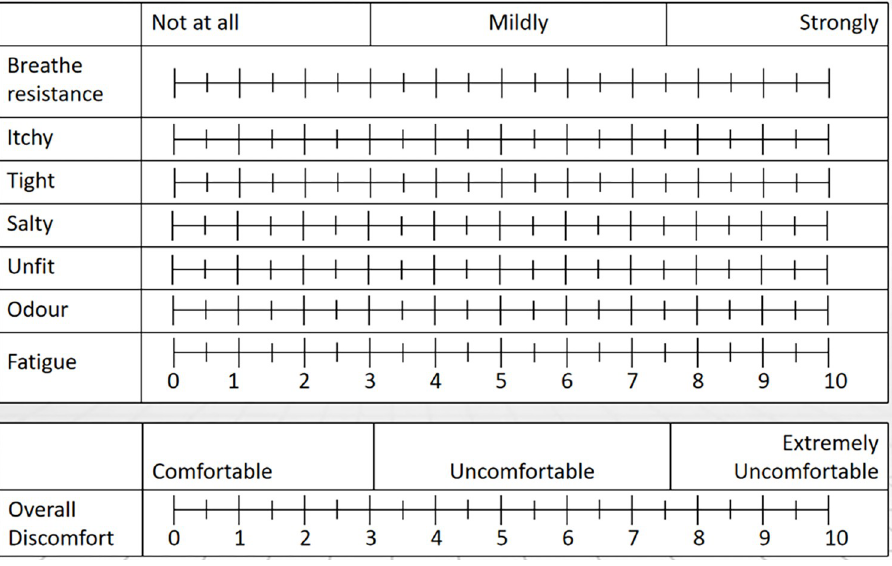
Fig 5. Rating scale of subjective perceived discomfort. Questionnaire of quantifying eight domains of comfort/ discomfort of wearing a mask.